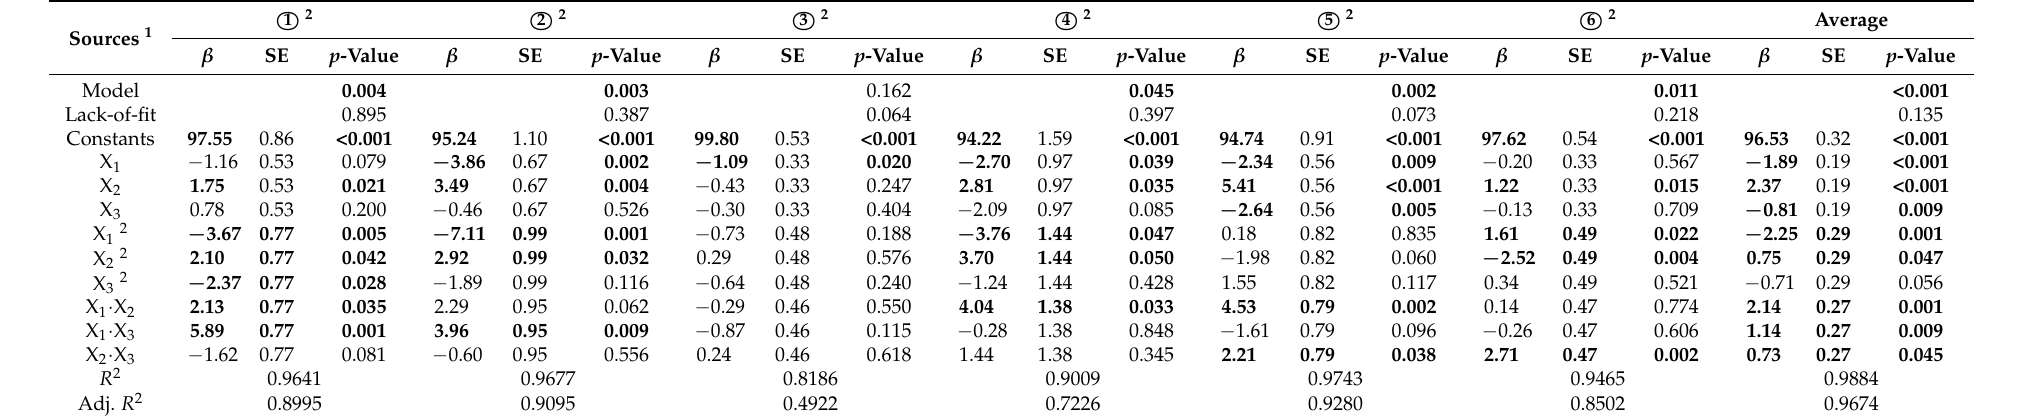
Table 3. Analysis of the models and regression coefficients for the disinfection efficiency for total bacteria at all